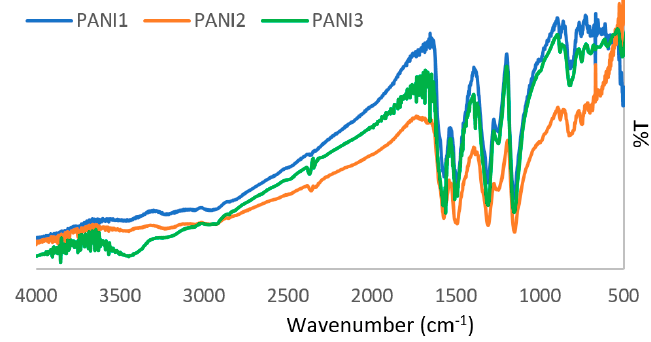
Figure 2. FT-IR spectra of PANI1, PANI2 and PANI3.